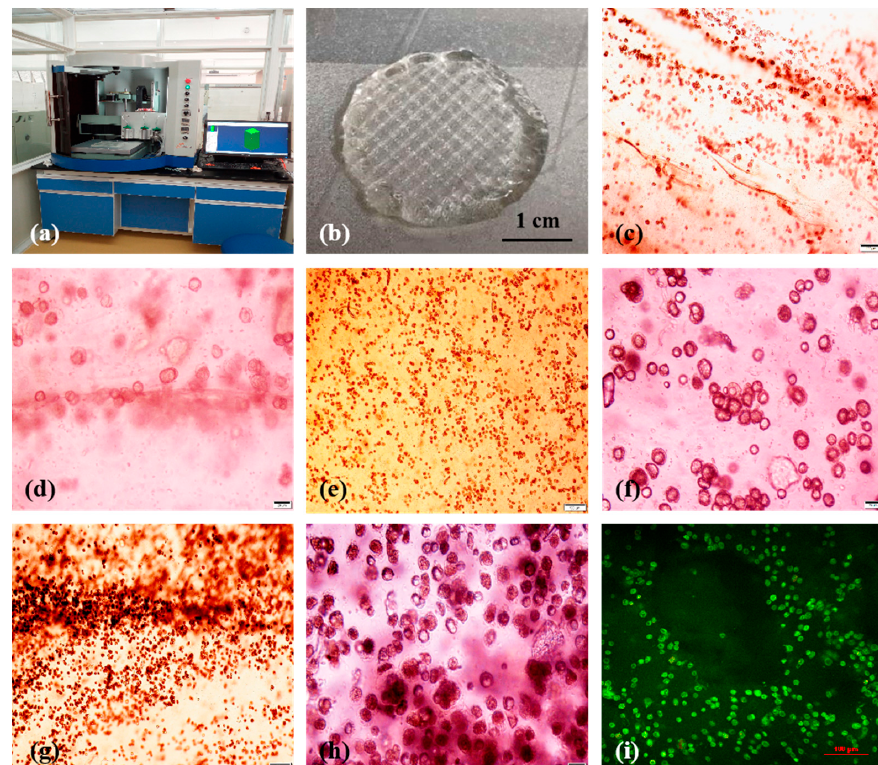
Figure 11. Three-dimensional (3D) bioprinting of cell-laden alginate/gelatin constructs for in vitro cultures: ( a ) a home-made three-nozzle 3D bioprinter, ( b ) a grid 3D construct made of SH-SY5Y cell-